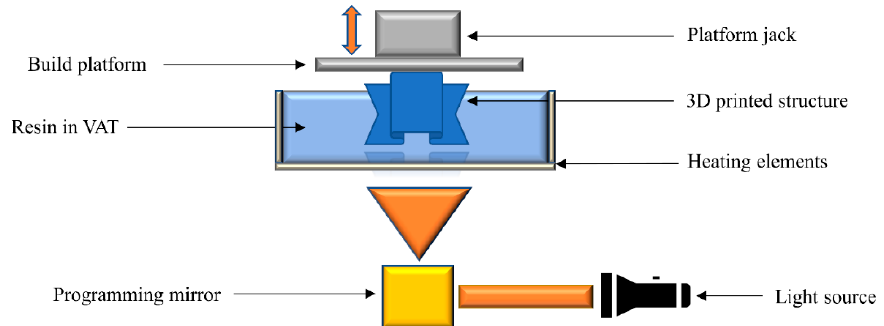
Figure 9. Schematic diagram of the hot lithography process.